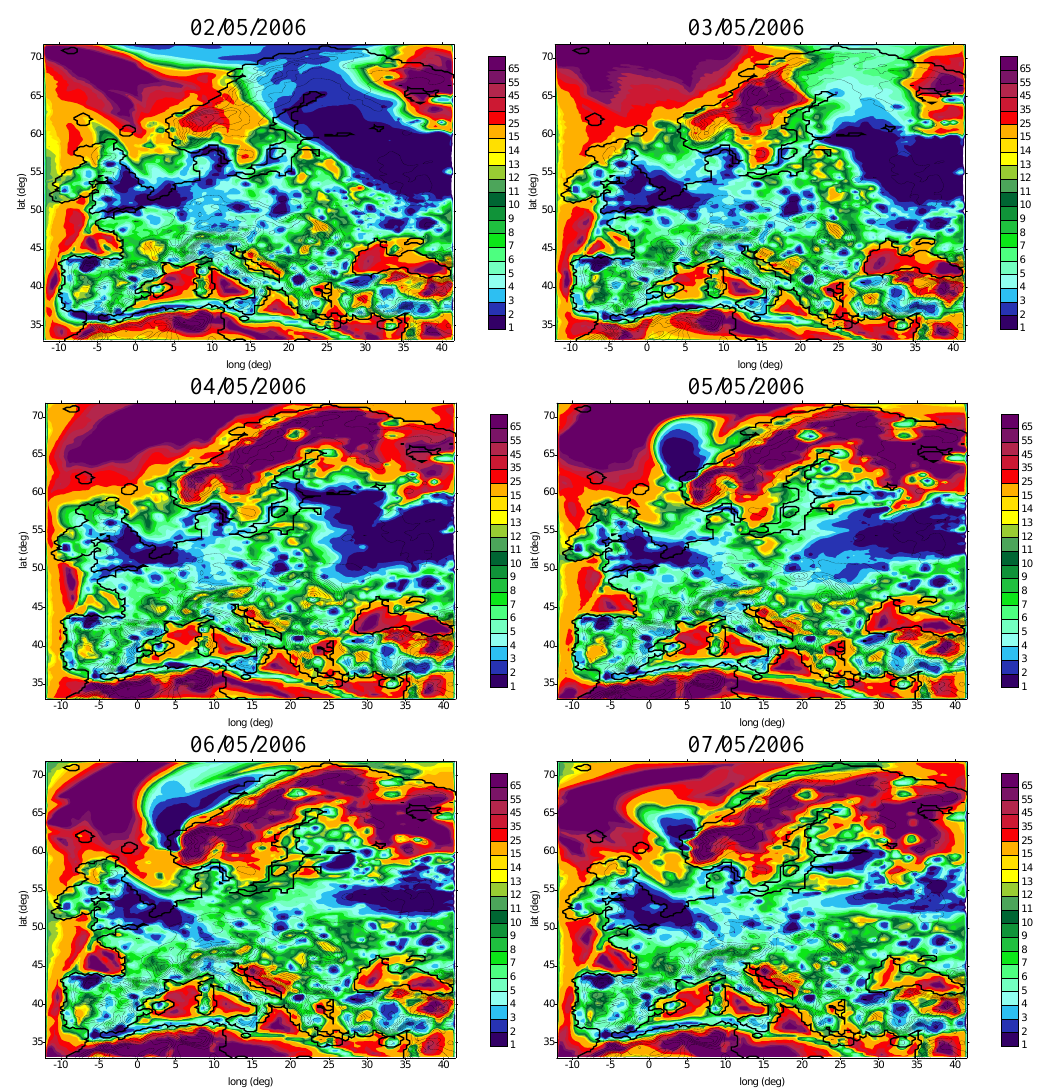
Fig. 5. Simulated VOC/NO x ratio for each cell (ppbCppb − 1 ), at the hour when the peak O 3 concentration occurred during the period 2–7 May